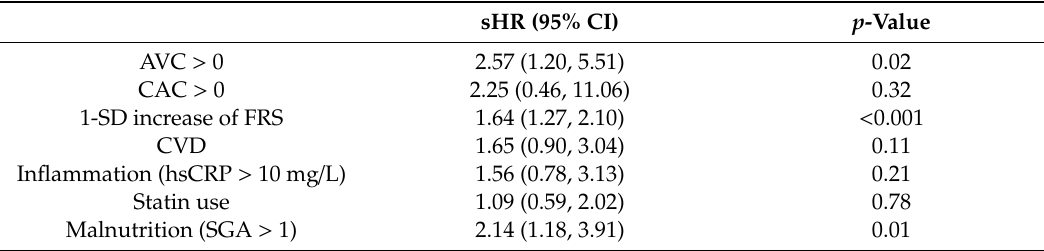
Table 2. Multivariate competing risk regression model of associations among AVC, CAC, inflammation and other factors with 5-year all-cause mortality in 259 ESRD